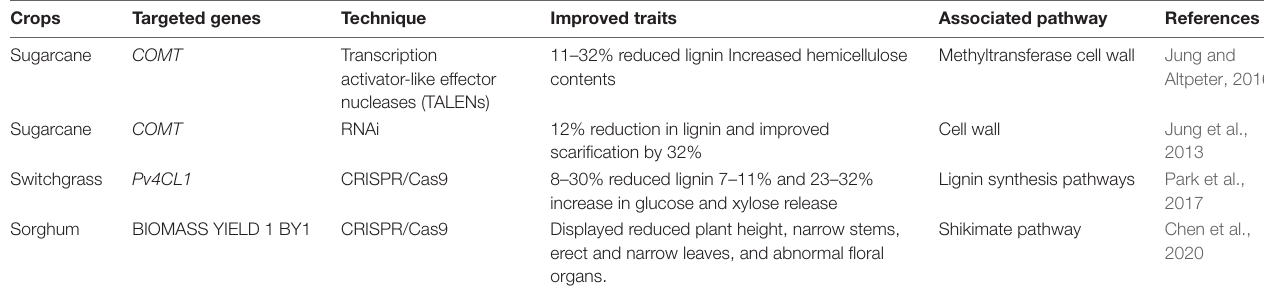
TABLE 2 | Few examples of genome editing techniques, engineering the C 4 plants for